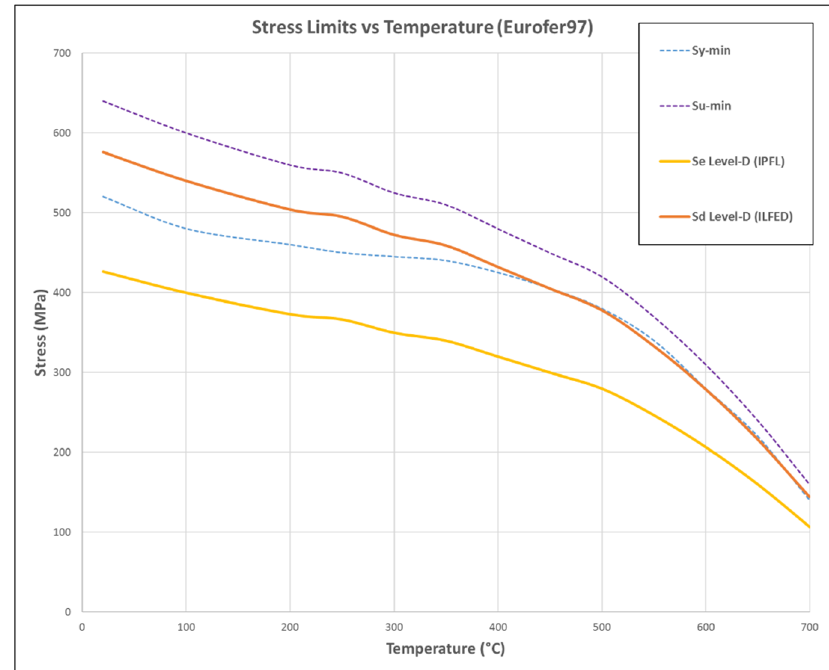
Figure 4. Stress limits with respect to temperature for Eurofer97 material.